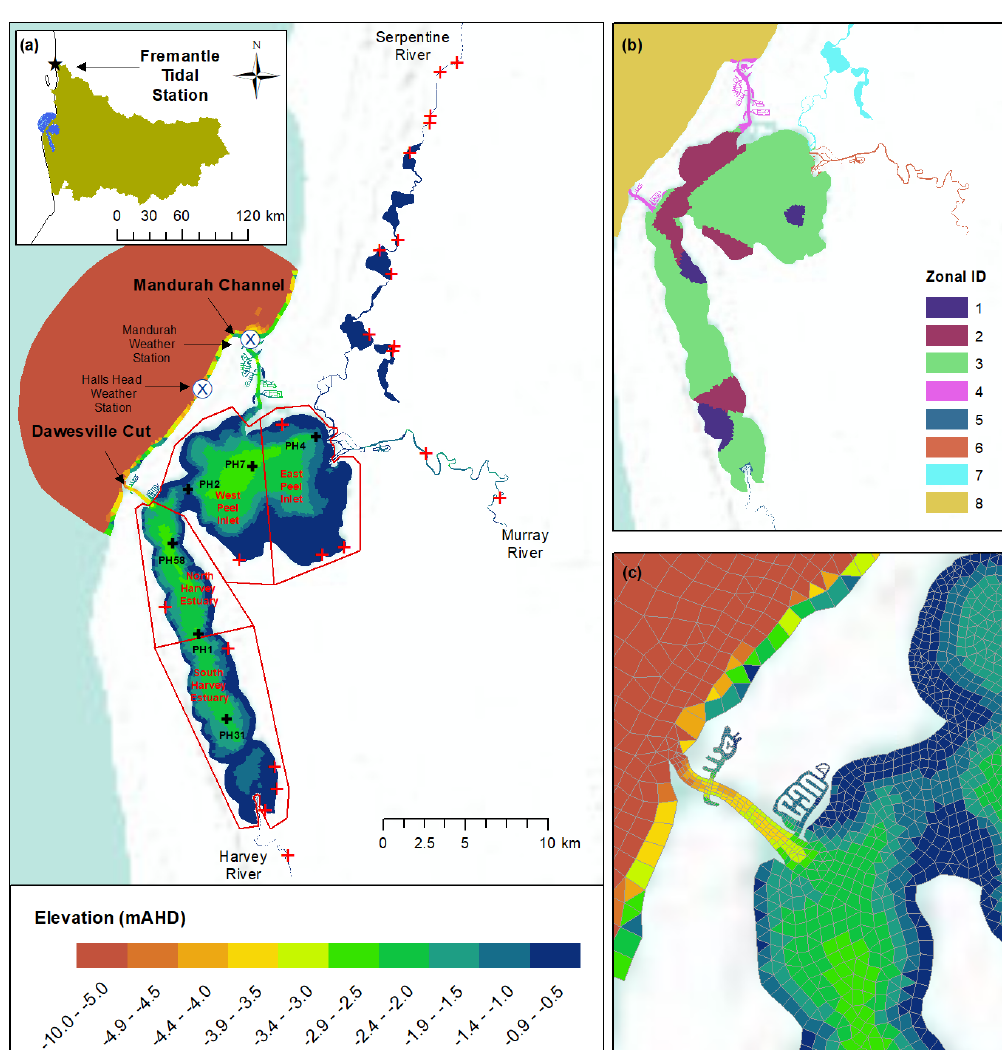
Figure 1. (a) Model domain of the Peel–Harvey Estuary and three main rivers: Serpentine River, Murray River and Harvey River; the tidal portion of each is depicted up to the gauge location. The colours indicate the water depths of the study domain in units of the Australian Height Datum (AHD); the black crosses within the estuary indicate the locations of six monitoring sites; the red crosses indicate the locations of ungauged flows entering the main rivers and estuary; the blue crosses indicate the location of weather stations; and the red polygons indicate the areas for analysis results. (b) Zonal categorization of the model domain according to the area and aquatic vegetation biomass (see Table 2); (c) a zoom-in view of the artificial channel Dawesville Cut, constructed in 1994 to improve ocean